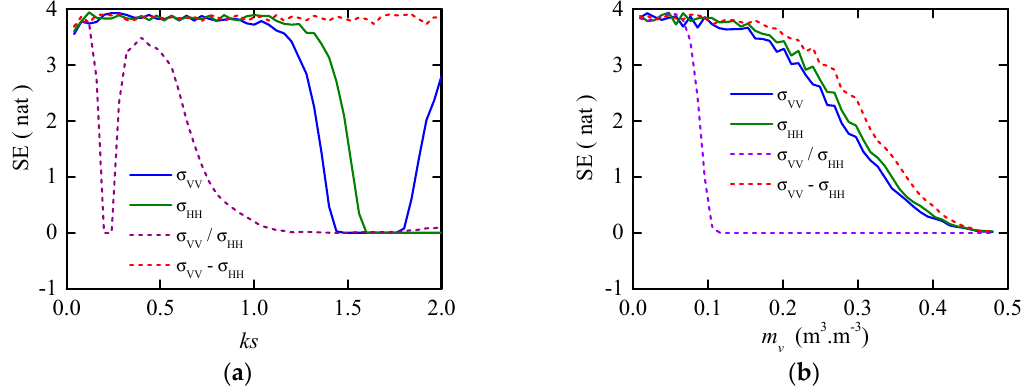
Figure 8. SE of single- and dual-polarization for varying: ( a ) ks . kl = 5.0, m v = 0.2 m 3 m − 3 ; and ( b ) m v . ks = 1.0, kl = 5.0 at θ i = 45 ◦